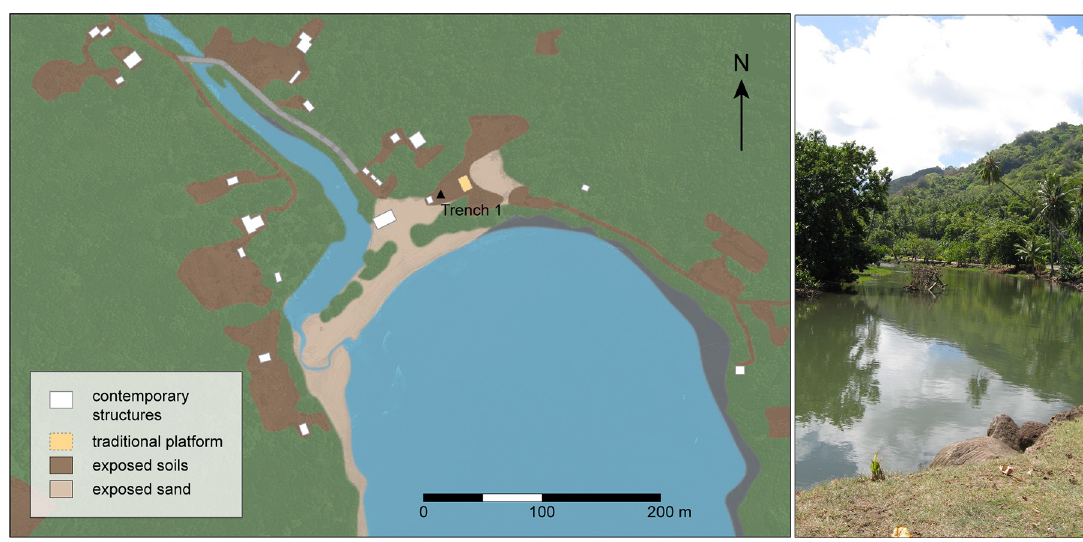
Fig 2. Map of Ho‘oumi Beach showing the location of Trench 1 (left) and an view of the river, looking upstream (right). (Photo by M.S. Allen).